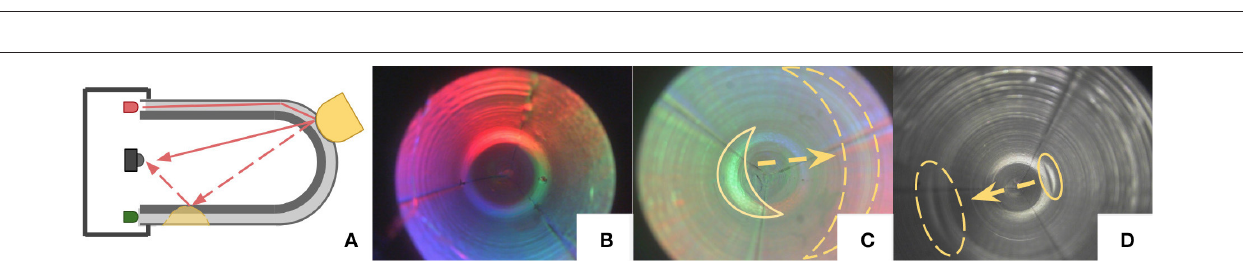
the discontinuity line. The tape width is approximately 14.5